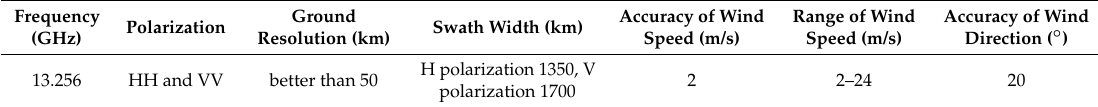
Table 2. The technical specifications of HY-2A microwave